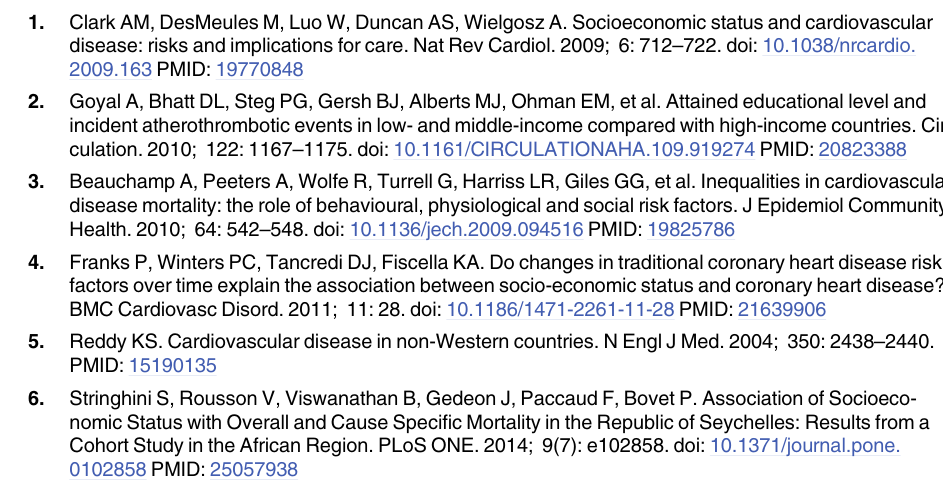
S1 Table. Change in mean CVHS based on AHA components only, without diet and physi- cal activity among participants by SES indicators in models variously